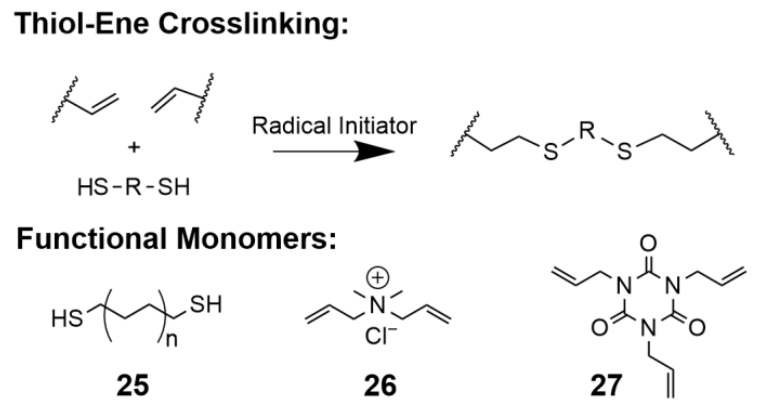
Figure 15. Thiol-Ene crosslinking and functional monomers used.